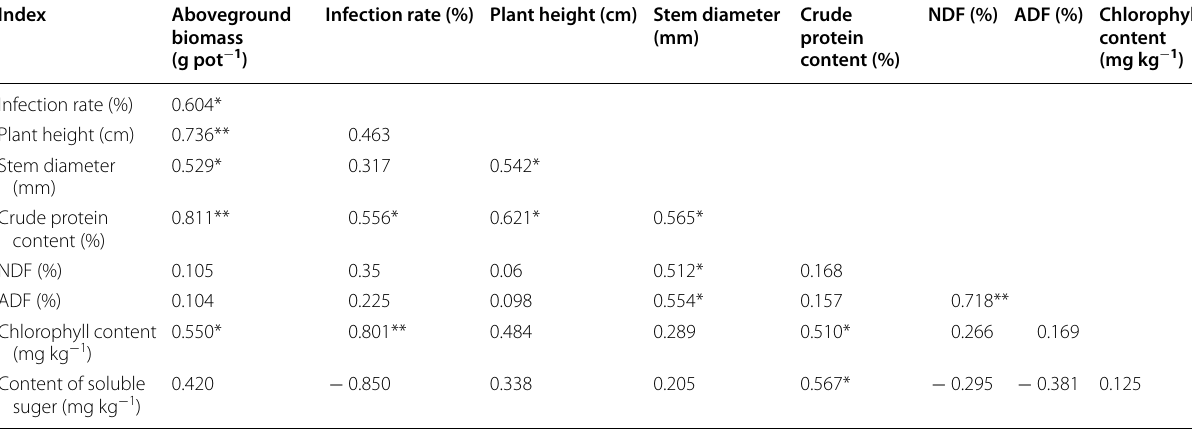
*Significant correlation was found at the 0.05 level (bilateral), **significant correlation was found at the 0.01 level